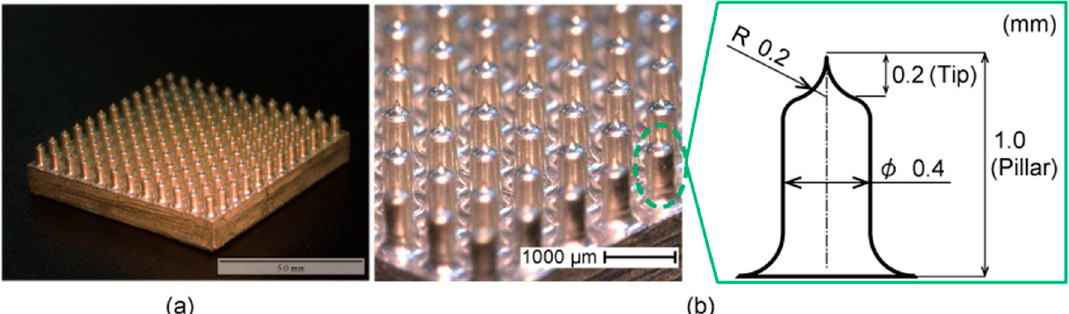
Figure 1. ( a ) Overview appearance of a candle-like microneedle electrode (CME). ( b ) An enlarged view of the array and the parameters of a pillar and its sharp tip. The wide bases allow them to avoid hair and the sharp tips penetrate the stratum corneum to reduce the contact impedance.